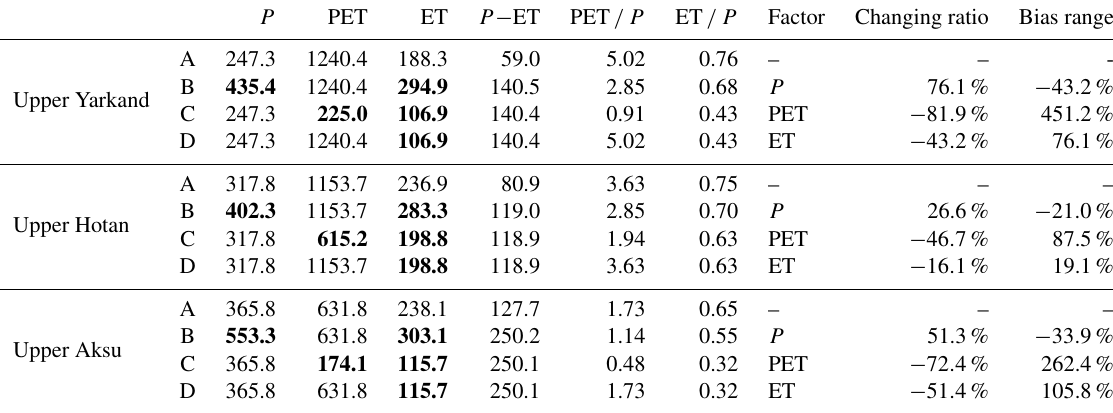
Table 5. The annual average values for different water–energy components ( P , ET, PET; units: mmyr − 1 ) and their relations ( P − ET, PET /P and ET /P ) for the three upstream subbasins. The scenarios correspond to the diagnostics of the current model (A) and three bias assumptions listed above from B to D. The bold values are the main factors changed within the three basic water–energy components. The changing ratio indicates the ratio of the changing value to the original value (unit: %), while the bias range implies the bias of the values in the current variables compared to the values they should be (unit: %).